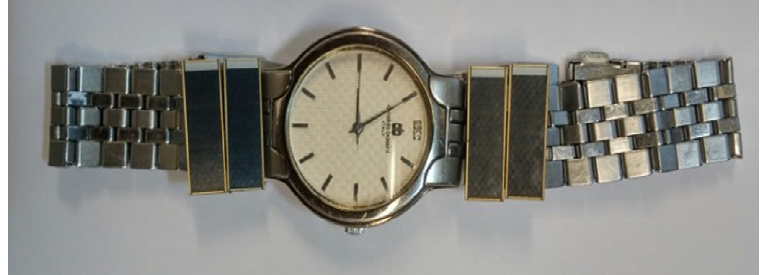
Figure 4. Four Type-1 PV cells were fitted on this wristwatch for light energy harvesting.